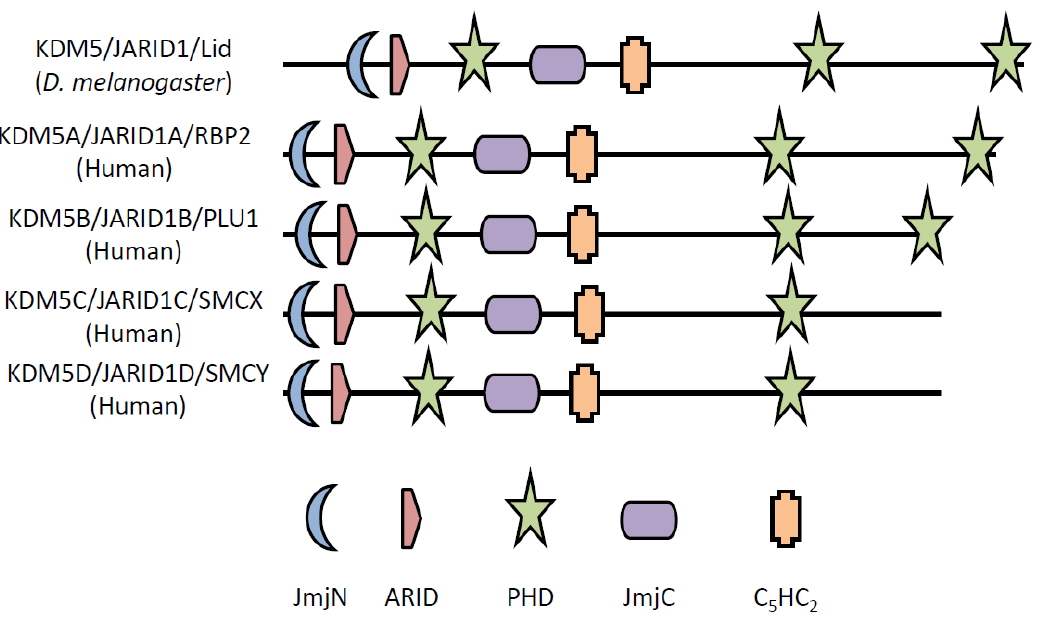
Figure 1. Domain structure of JARID1 proteins from Drosophila and